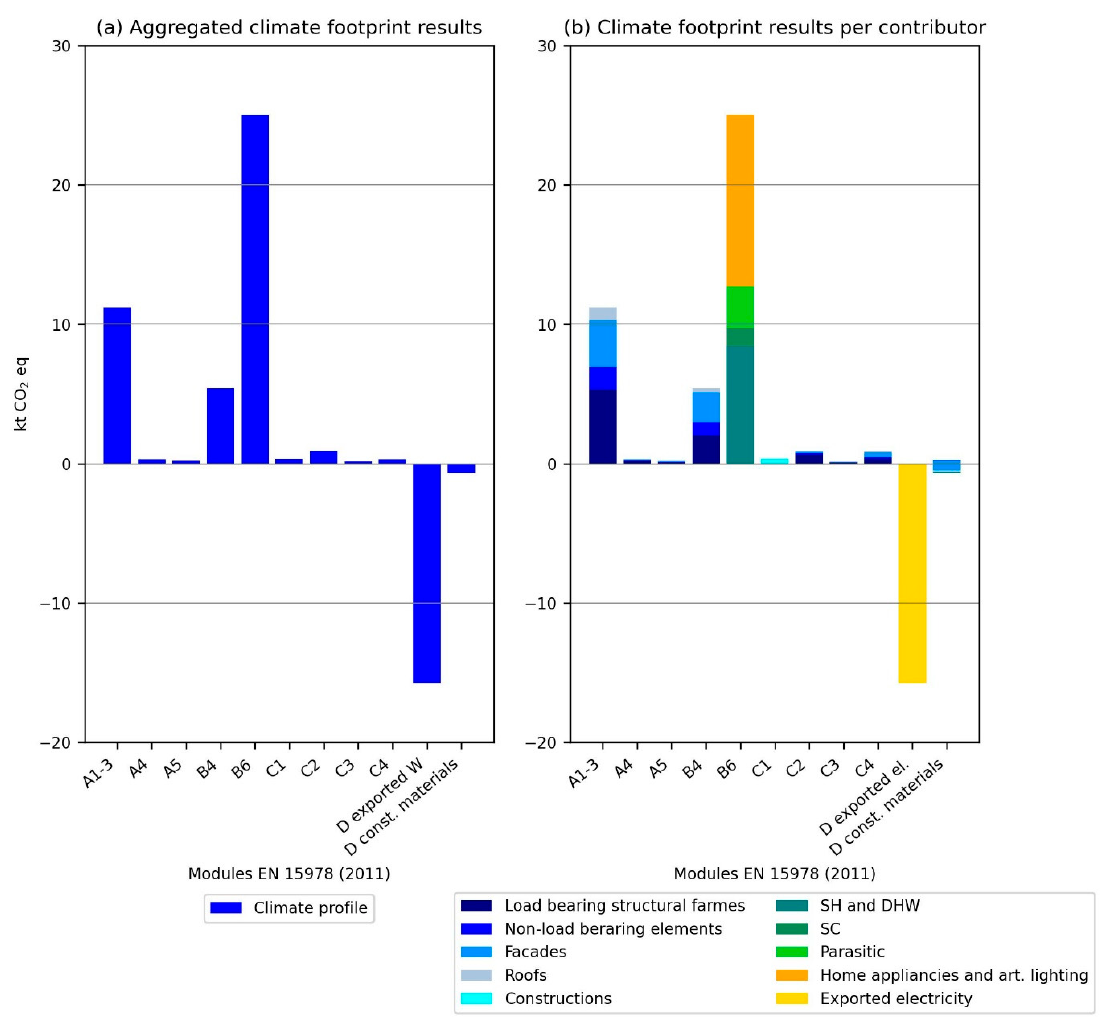
Figure 8. Climate footprint results—of each module ( a ) and of each module divided according to the parts described in the scope ( b ).